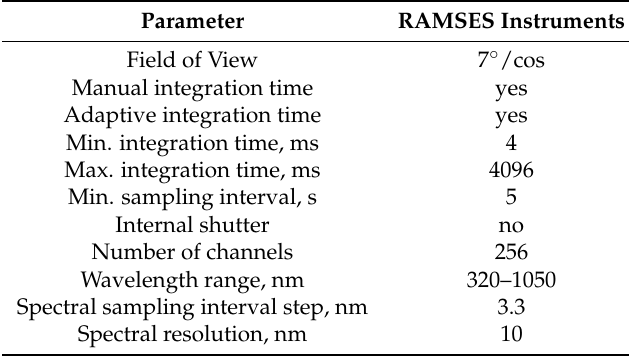
Table 1. Technical parameters of the instruments